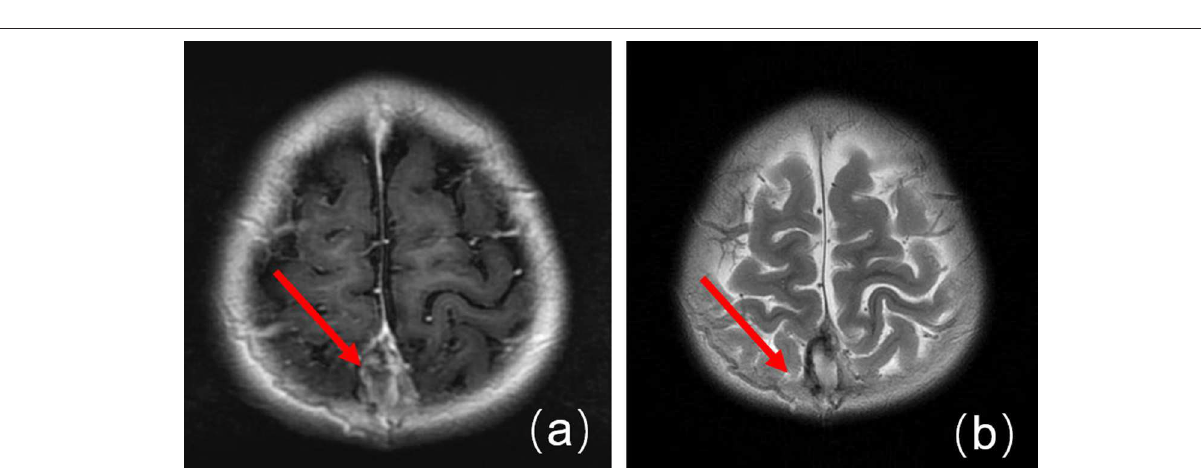
gradually accepted the “gold standard” for CVST diagnosis which uses the combined application of enhanced MRI and MRV examination